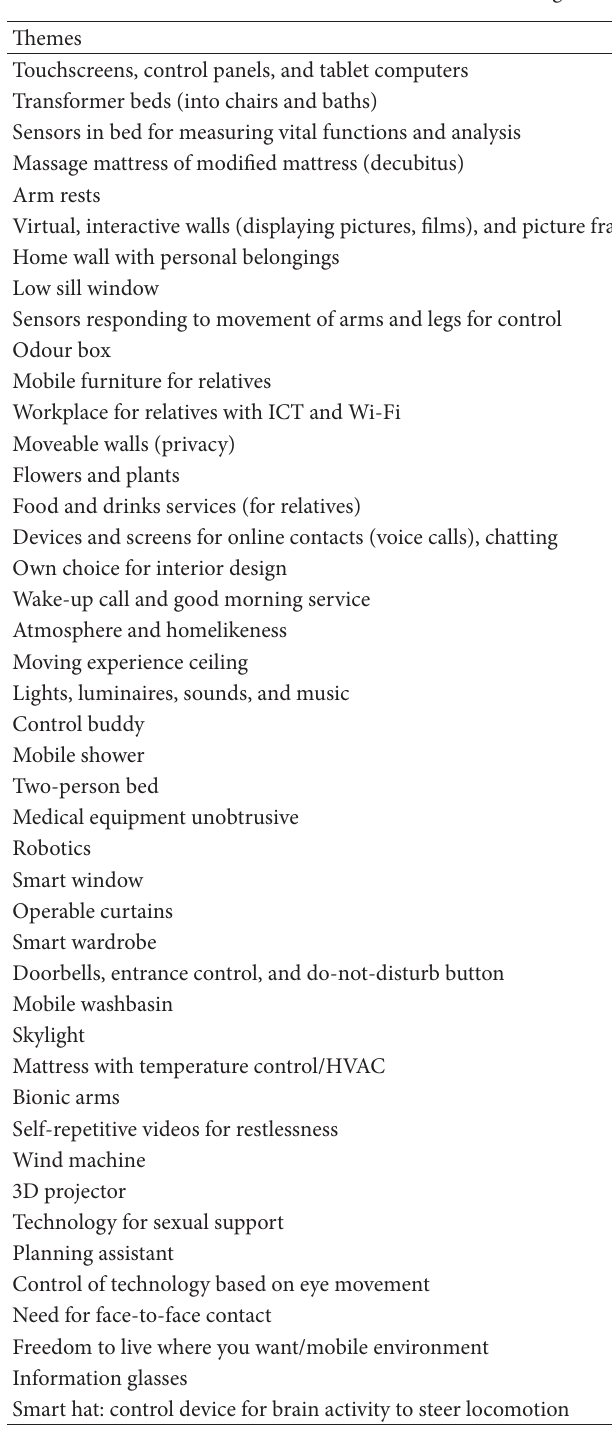
Table 2: Themes or design concepts emerging from the